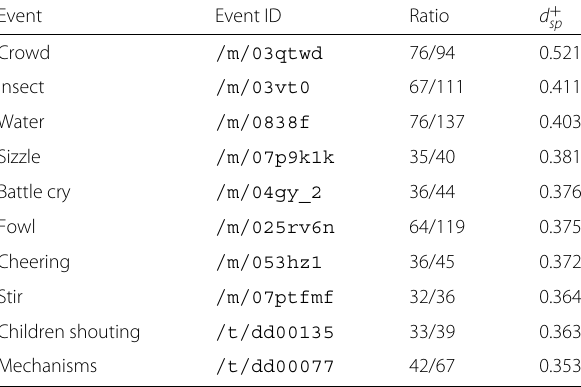
labels related to false positive decisions of the network about the “Speech”